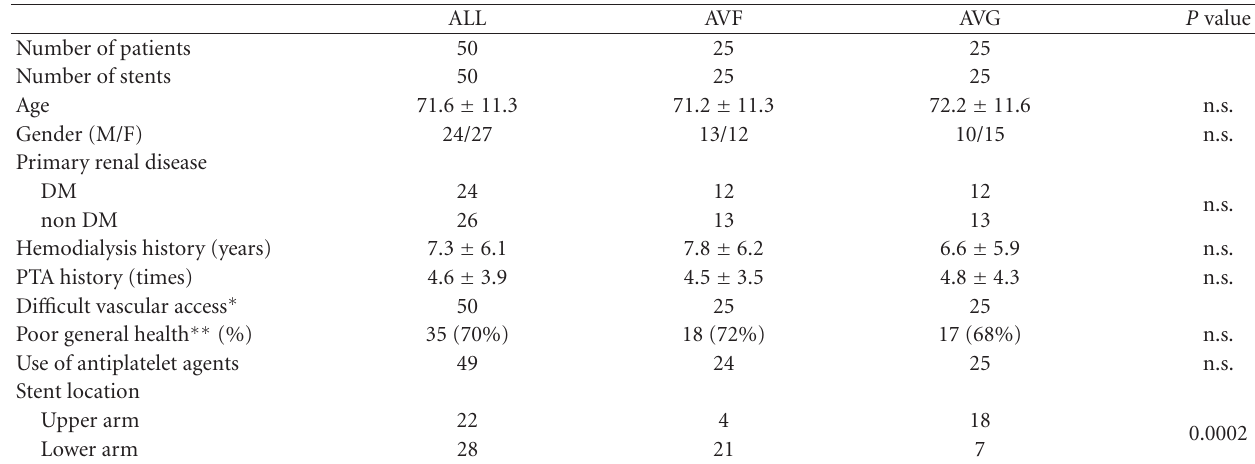
Table 1: Patient characteristics. Twenty-five SMART stents each were deployed in AVF and AVG cases. There was no significant di ff erence, other than stent location, between the backgrounds of the patients in the two groups.